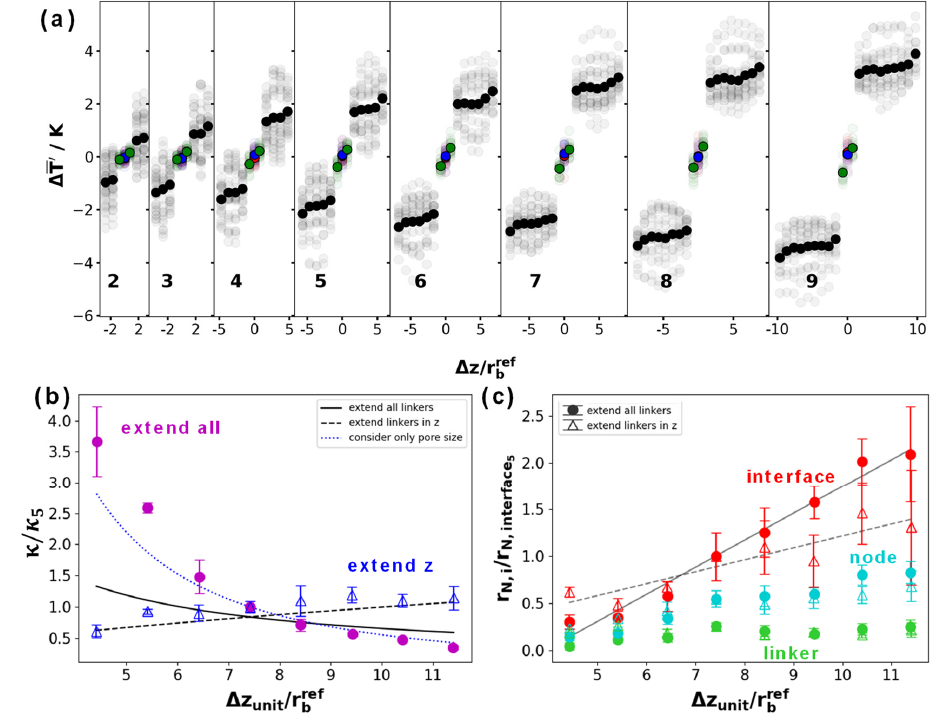
Figure 6. ( a ) Local effective temperature profiles of a node and its adjacent linkers obtained from NEMD simulations for isotropic model systems with different numbers of “virtual atoms” contained in the linkers. The temperature profiles have been averaged across all building blocks that are not within a distance of 50 Å from the center of the thermostat. The semi-transparent data points in the background represent the local effective temperatures before spatial averaging. The labels indicate the number of atoms in each linker. The total length of the simulation cells was fixed to be approximately equal for all systems. For different numbers of atoms in the linker, this leads to the following super cells of the conventional unit cell: 2: 52 × 8 × 8, 3: 42 × 6 × 6, 4: 36 × 4 × 4, 5: 32 × 4 × 4, 6: 28 × 4 × 4, 7: 26 × 4 × 4, 8: 24 × 4 × 4, 9: 22 × 4 × 4. ( b ) NEMD-calculated thermal conductivities of the model systems with the numbers of “virtual atoms” varying in all directions (magenta) and varying only in one direction (blue). The values are reported relative to the thermal conductivities of the system containing 5 “virtual atoms” in each linker. The absolute values for κ are reported in the Supplementary Materials Section S5 together with the used force field and distance parameters. The error bars originate from the error of the infinite size extrapolation. The black lines indicate the predictions for extending linker lengths in all directions (solid line) and only in the heat transport direction (dashed line). The dotted blue line indicates the prediction when only considering the decrease in the linker density due to longer linkers. Panel ( c ) shows transport-channel insulances of nodes, linkers, and interfaces of the model systems for extending the linkers in all directions (filled symbols) and for extending the linkers only in the heat transport direction (empty symbols). Again, the values are reported relative to the interface thermal transport-channel insulance of the system containing 5 “virtual atoms” in each linker and the absolute values for r N , i are reported in the Supplementary Materials, Section S5. The error bars originate from the standard error of the infinite size extrapolation. Linear fits through the interface transport-channel insulances are indicated in grey to provide a guide for the eye. The length values ∆ z in (a,b,c) are reported relative to the bonding distance between “virtual atoms” in the model systems, r ref